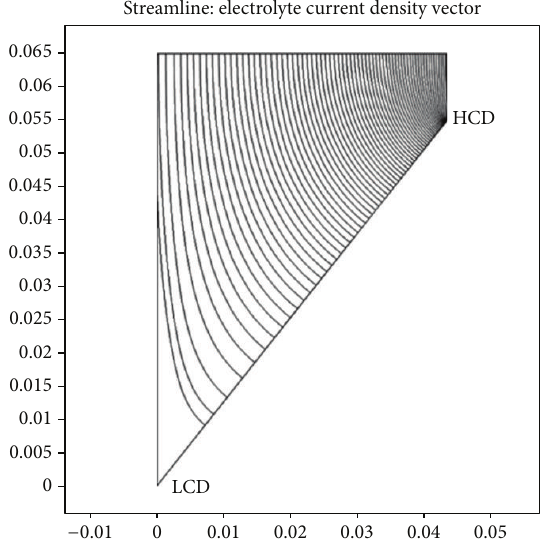
Figure 5: Comparison of current density distribution in a modified Hull cell [solid red color line joining solid stars] with an empirical formula [black color line] [25] and an analytical solution for standard Hull cell [blue color dots] [19].